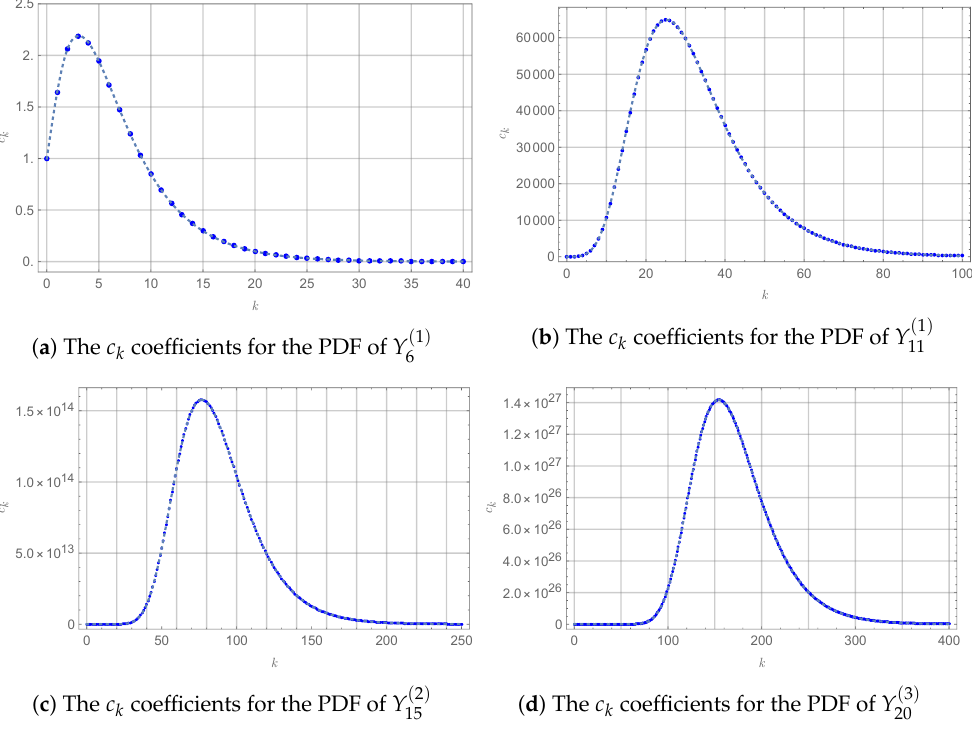
( j ) = 1,2,3 set in n , j